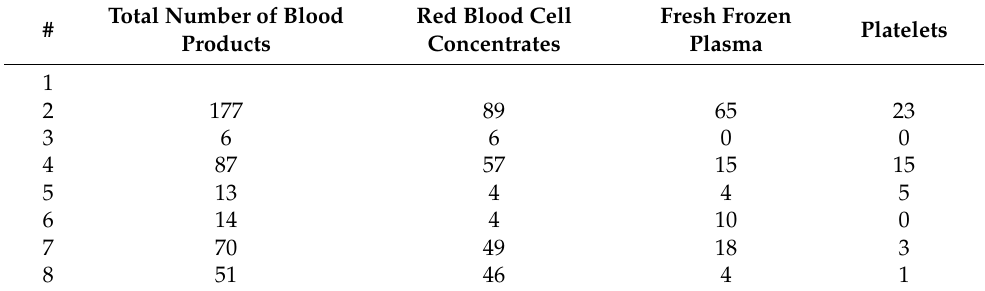
Table 3. Number of administered blood products.